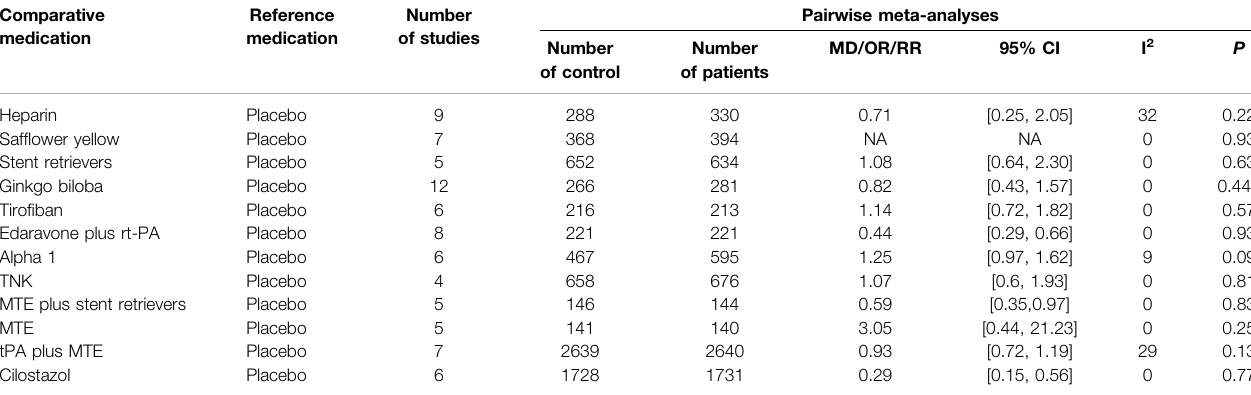
TABLE 7 | Results of pairwise meta-analyses for extracranial hemorrhage. Comparative medication